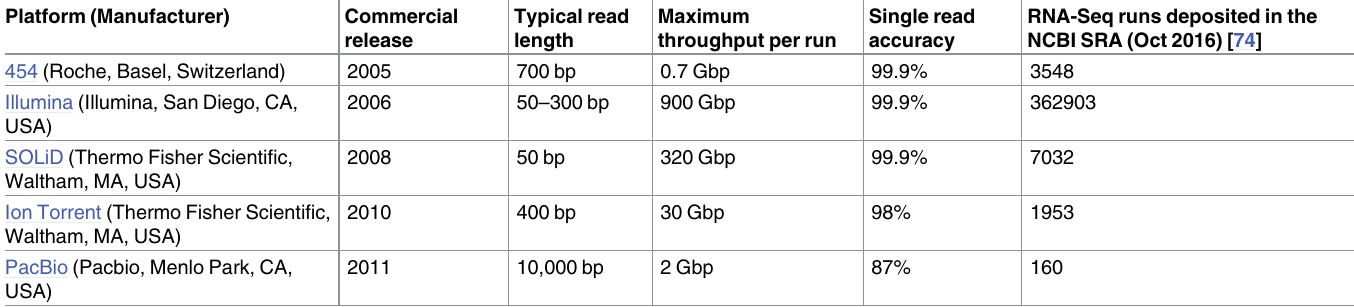
Table 2. Sequencing technology platforms commonly used for RNA-Seq